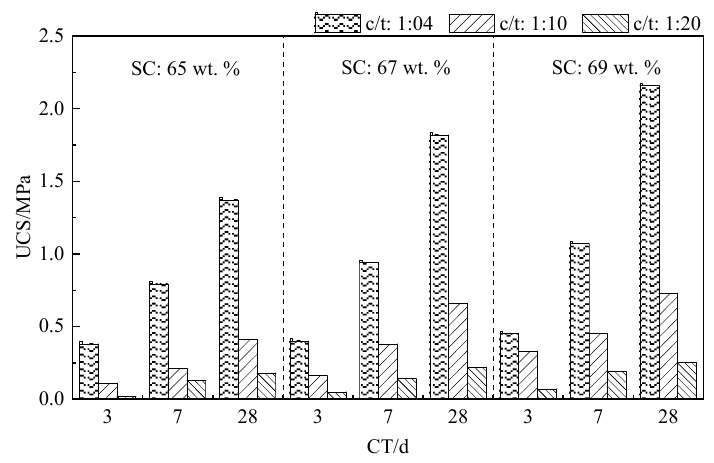
Figure 10. Relationship between CT and UCS of CTB mixes.